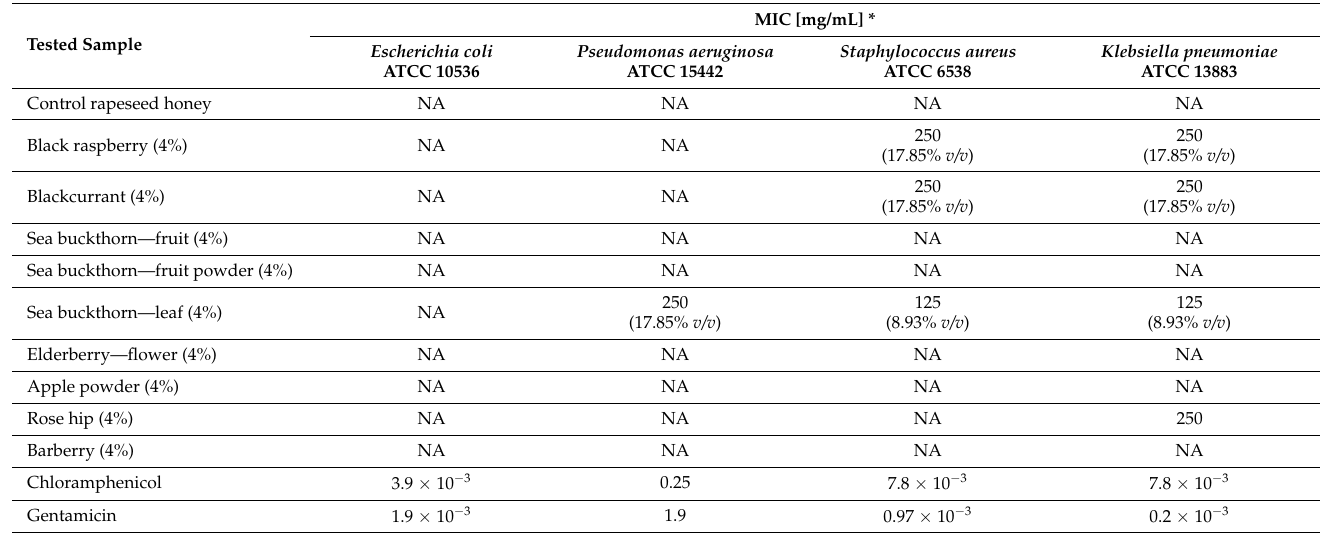
Table 2. Minimal inhibitory concentration (MIC) values determined for the prepared